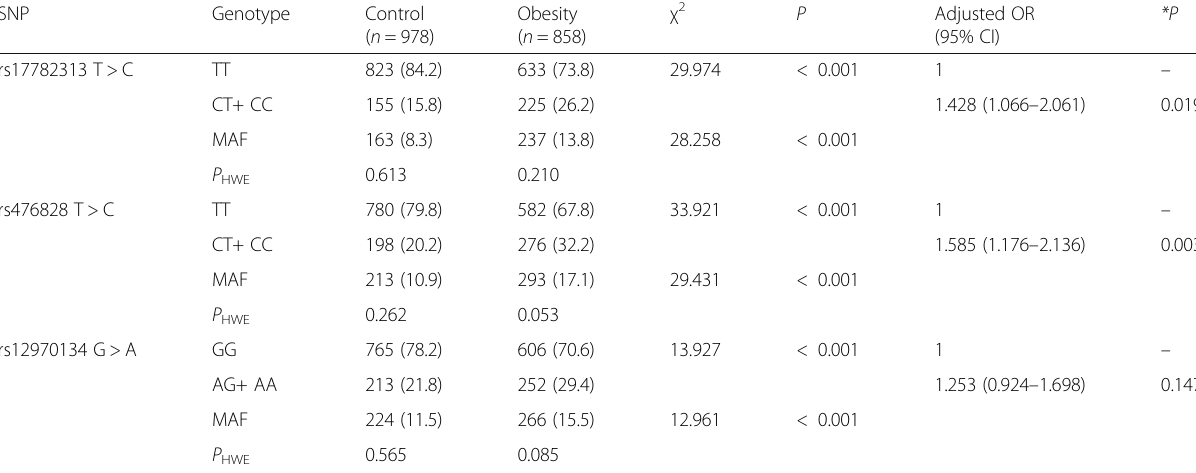
Table 2 The correlation between the MC4R polymorphisms and the risk of obesity [n (%)]